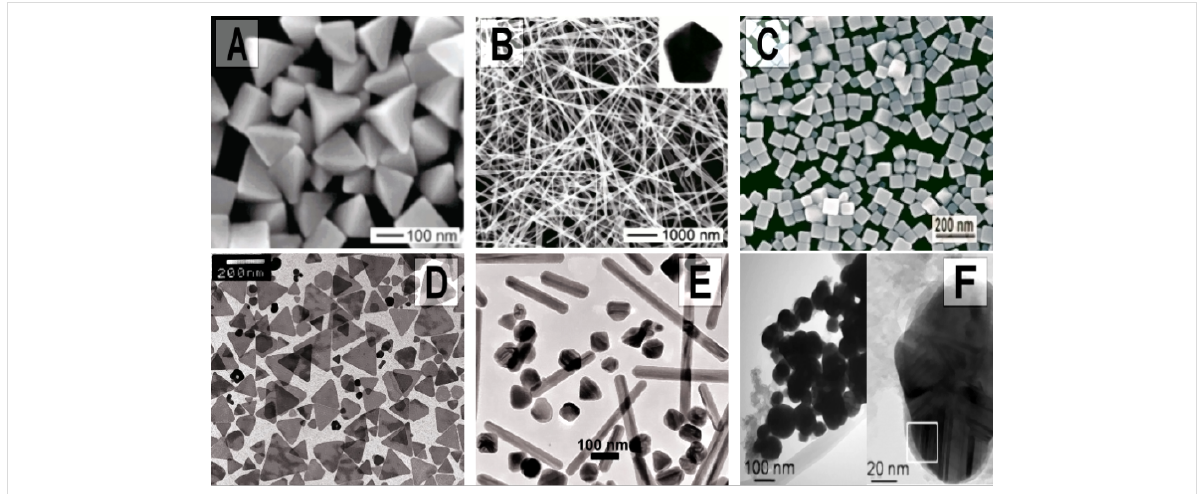
Figure 1: Scanning electron microscope (SEM) with different morphologies: (A) bipyramidal, (B) nanowires, (C) nanocubes and transmission electron microscopy (TEM) micrographs of AgNPs with different morphologies: (D) nanoplates, (E) mixture of spheres and nanorods, (F) spherical bimetallic core–shell Ag@Fe, silver core with iron shell. Part A reprinted with permission from [37], Copyright 2006 American Chemical Society; part B reprinted with permission from [38], Copyright 2005 American Chemical Society B; part C was reprinted from [39], Chemical Physics Letters, vol. 427, by J. M.